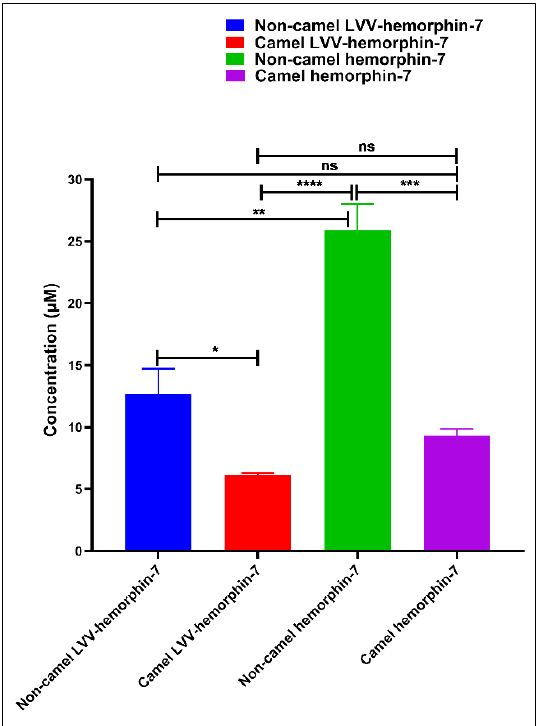
Figure 7. Half maximal inhibitory concentration (IC 50 ) of both camel and non-camel hemorphins. IC 50 values are expressed in micro molar (µM) units and comparisons of IC 50 was done using one-way ANOVA and Sidak’s multiple -comparisons test to measure statistical significance between different hemorphins. Data are represented as mean ± SEM of three independent experiments. **** p < 0.0001 , *** p < 0.001 , ** p < 0.01 , * p < 0.05, and ns p > 0.05 .